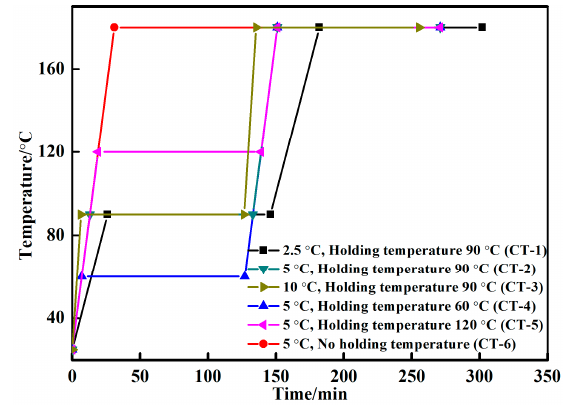
Figure 3. Curing temperature curves of the inorganic phosphate adhesive.